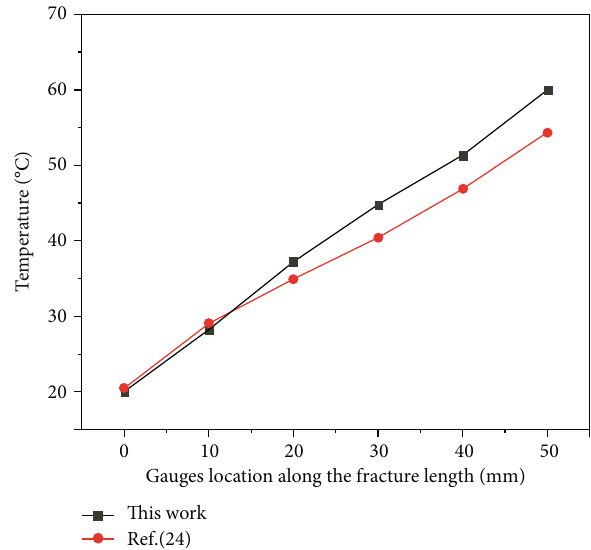
Figure 6: Comparison of the simulation results of this work with the existing